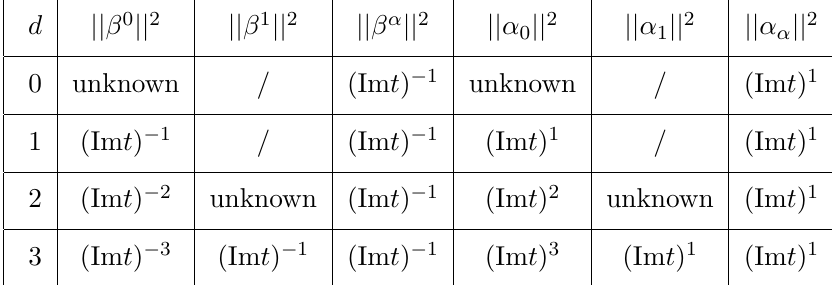
where (cid:11) = 1 ; : : : ; i 2 ; 2 and a = 1 ; : : : ; i 2 ; 1 . The basis elements (cid:11) In this adapted basis a charge vector generating an in(cid:12)nite orbit takes the